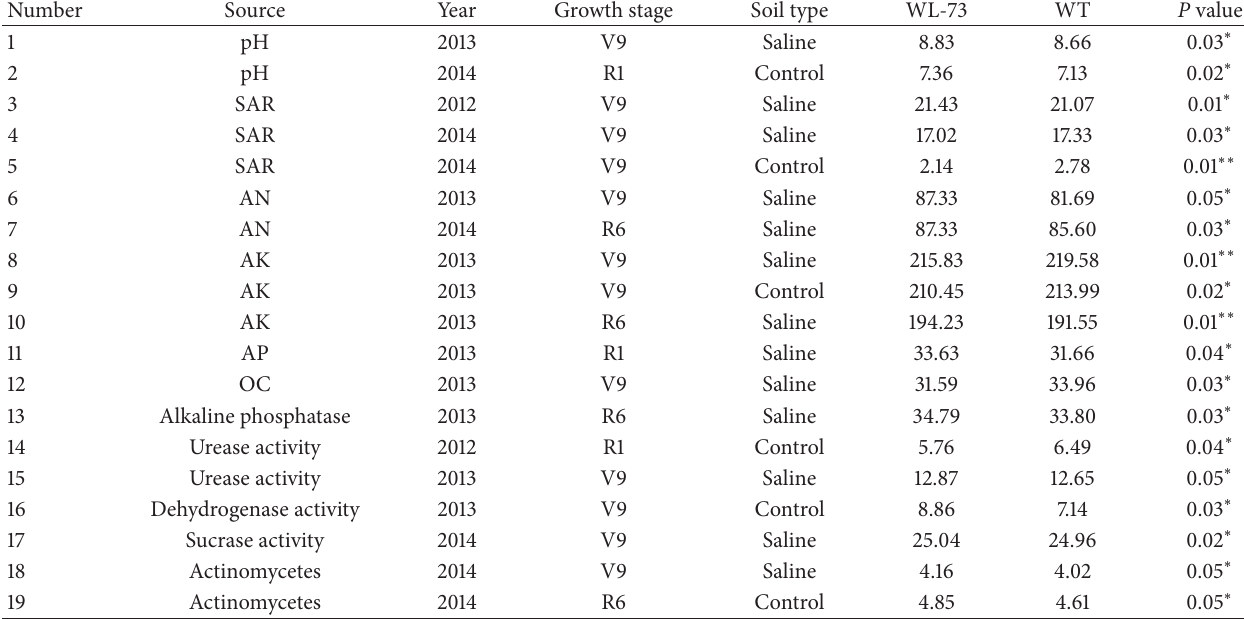
Table 3: ANOVA of the effects of year, growth stage, soil type, and maize genotype.